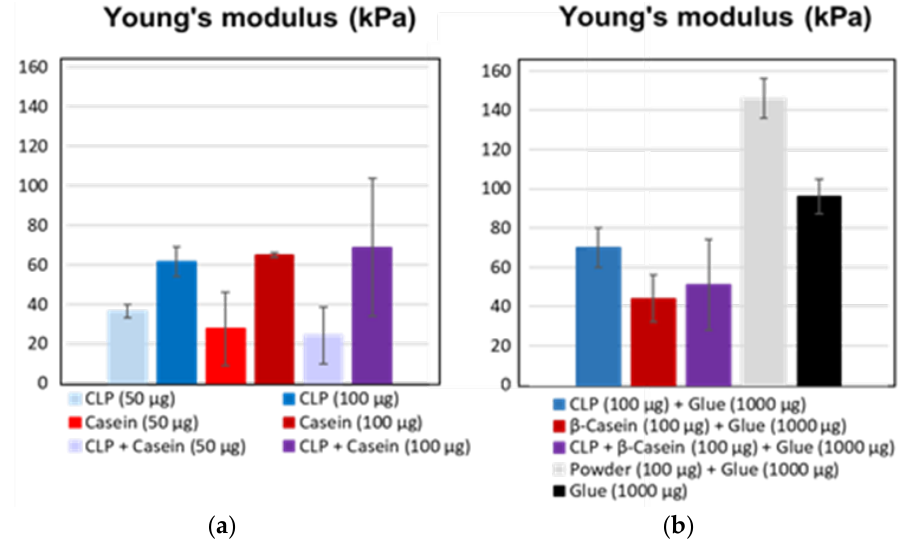
Figure 8. Young’s modulus for ( a ) CLPs, β-casein and CLPs coated with β-casein using two quantities. ( b ) Corresponding histograms for the NPs dispersed in diluted adhesive including the references.